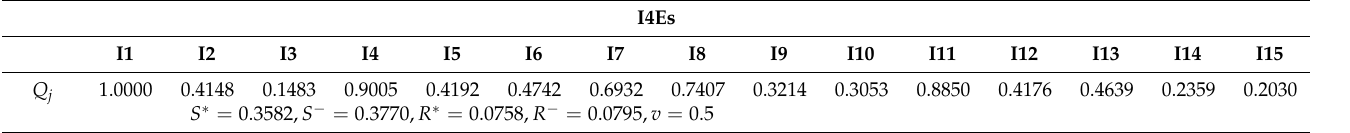
Table A8. Calculation results of benefit ratio Q j